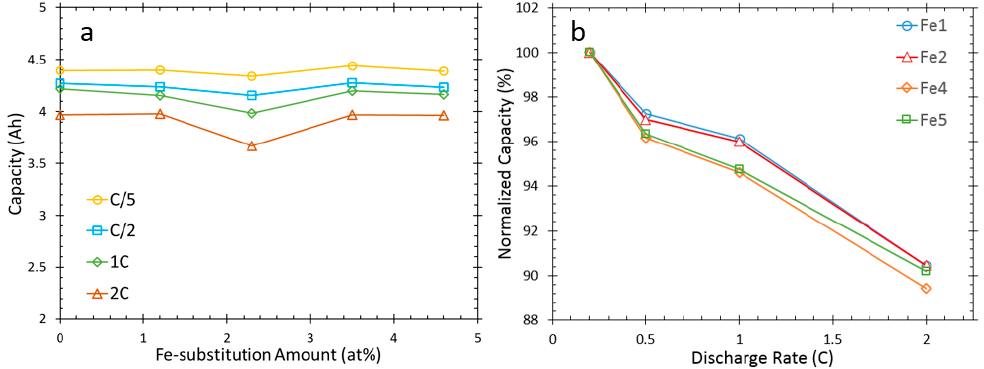
Figure 2. ( a ) Cell capacities at different rates as functions of the amount of Fe-substitution in the alloy and ( b ) normalized capacities as functions of discharge rate for cells Fe1, Fe2, Fe4 and Fe5.